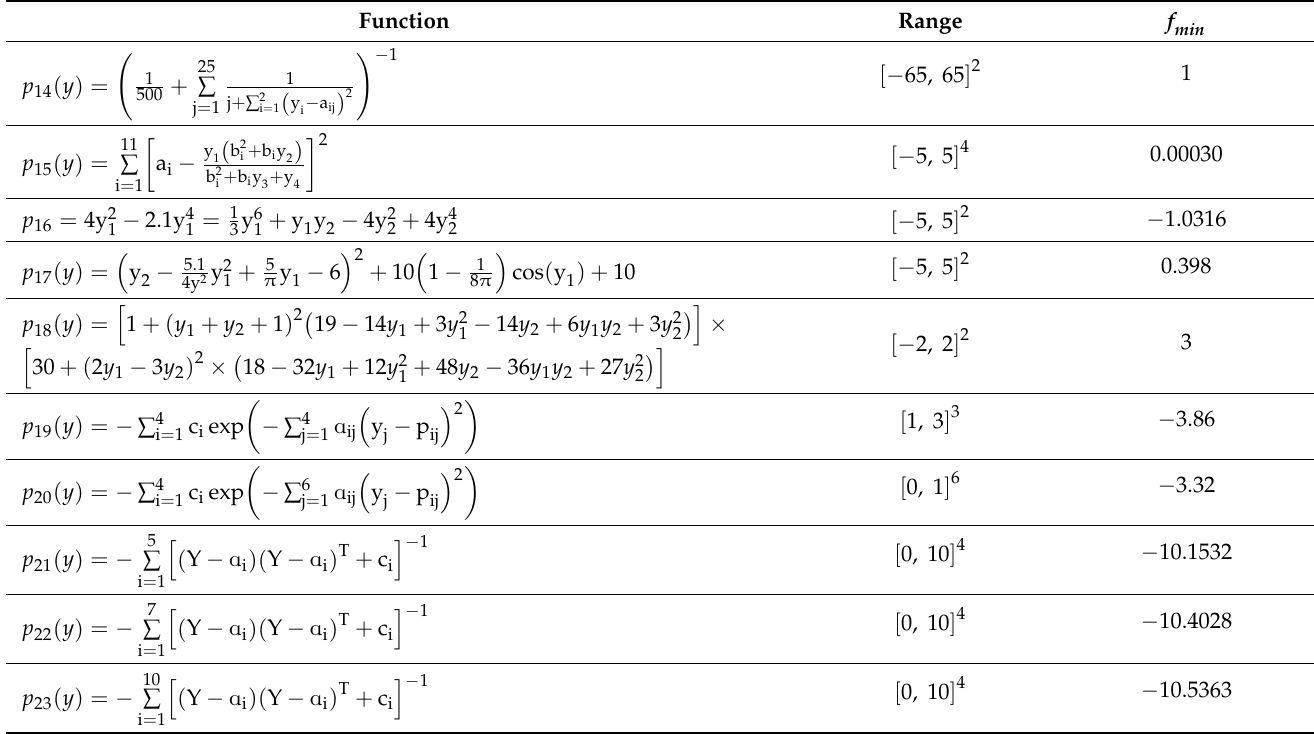
Table 5. Fixed dimension multimodal benchmark functions.